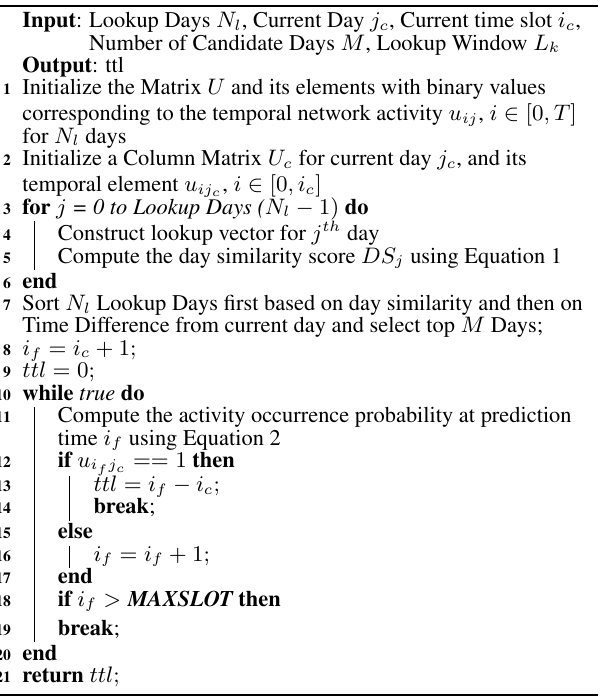
Algorithm 1: The Network Activity Prediction